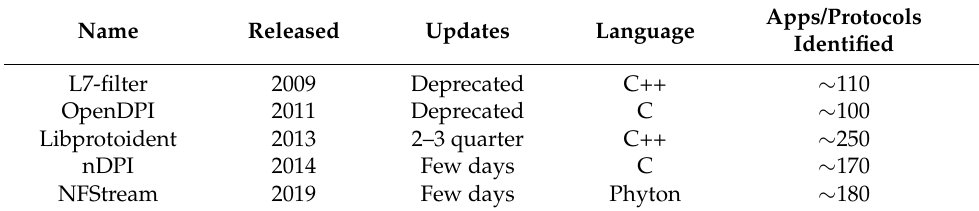
Table 3. Comparison between different DPI algorithms